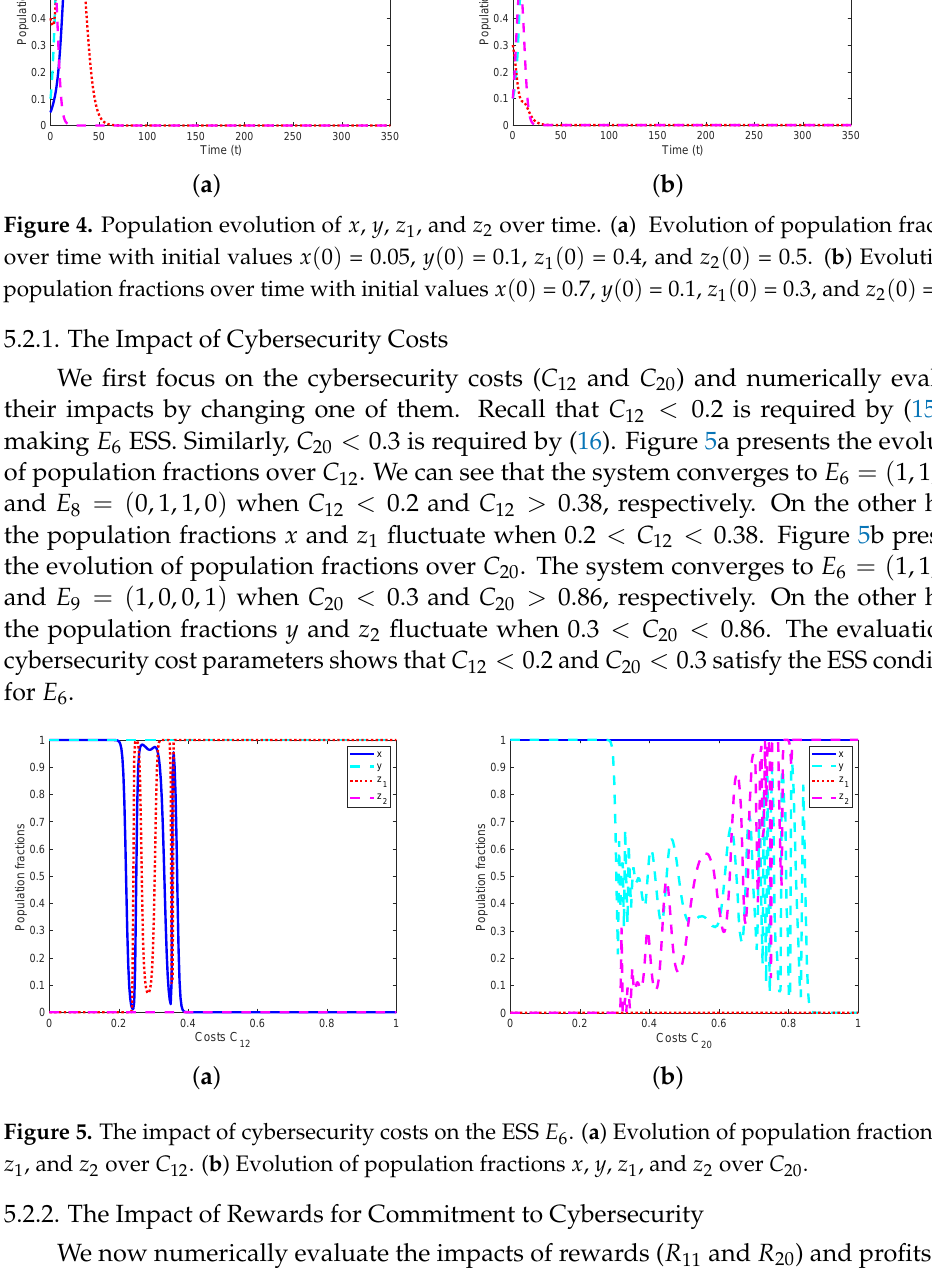
red line, and a dashed magenta line to describe the evolution of population fractions x ( t ) , y ( t ) , z 1 ( t ) , and z 2 ( t ) , respectively.